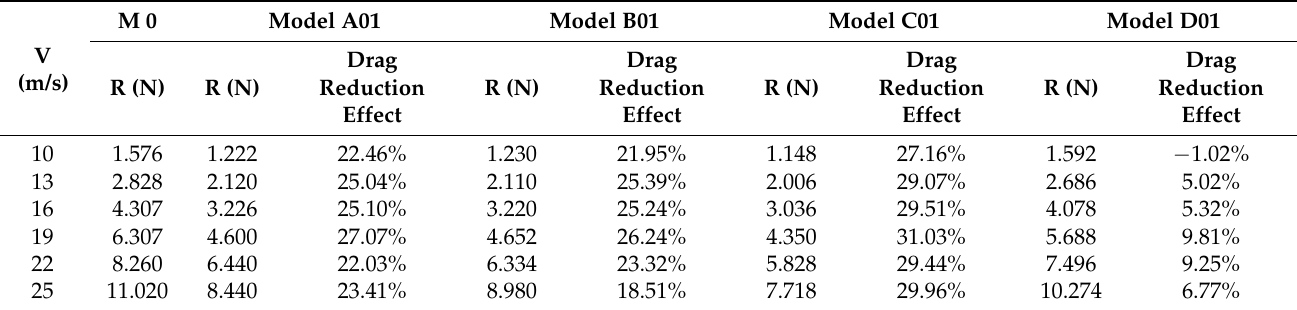
Table 5. Resistance and drag reduction effect of arc stern model.